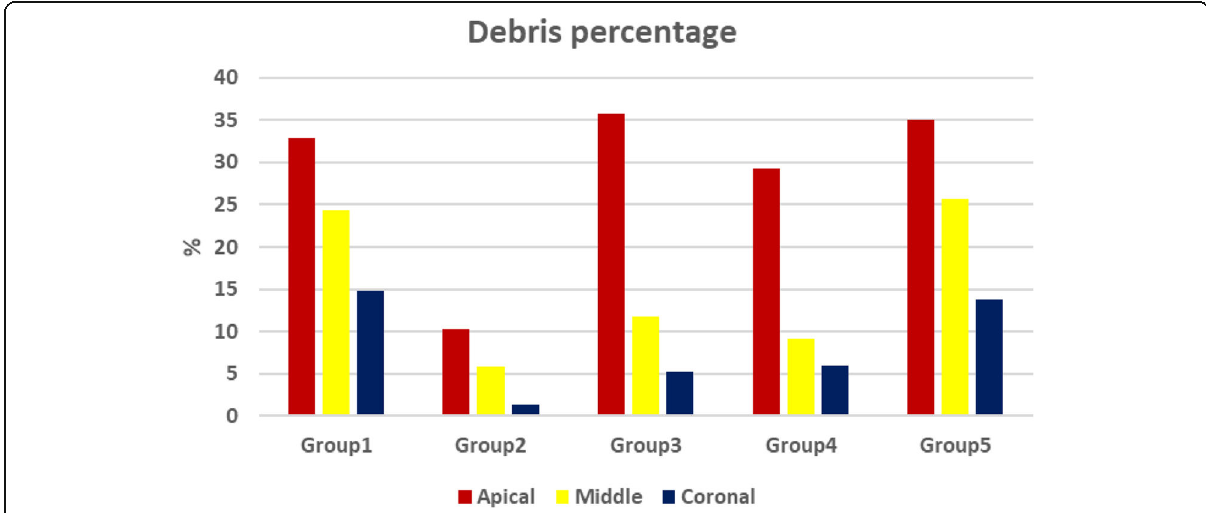
Fig. 5 A histogram representing the debris percentage for different